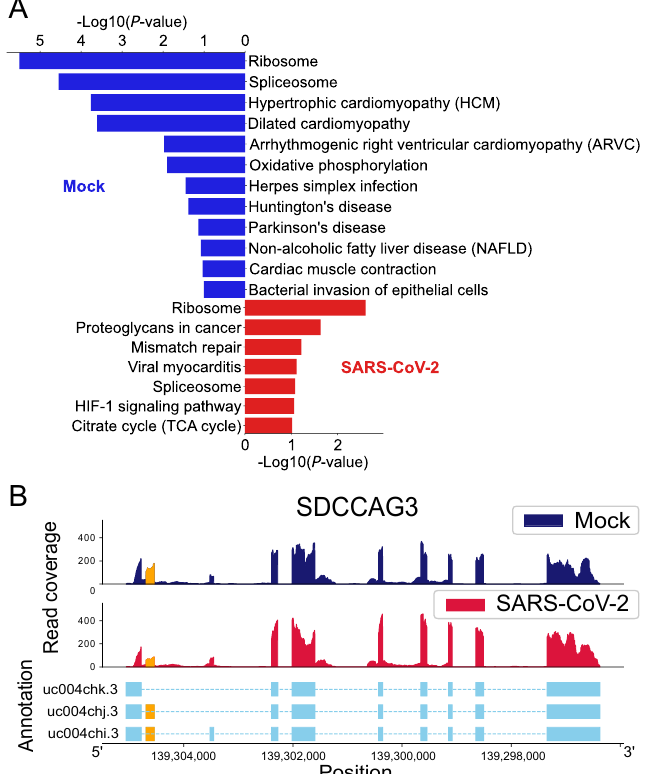
Figure 2. ( A ) KEGG pathways enriched by alternative splicing events. The blue and red bar charts show the pathways enriched by the splicing events in mock-treated cells and SARS-CoV-2 infected cells, respectively. ( B ) A plot for the SDCCAG3 AS event. The spliced exon is highlighted in orange. The first two subplots show the read coverage of the gene in both groups, whereas the bottom subplot denotes the gene annotation with exon information. The x -axis and y -axis of the plot represent the position of the specific gene and read coverage of that sample, respectively. To show the differential splicing event, the altered exon is highlighted in orange to provide a clear insight into the phenomenon.